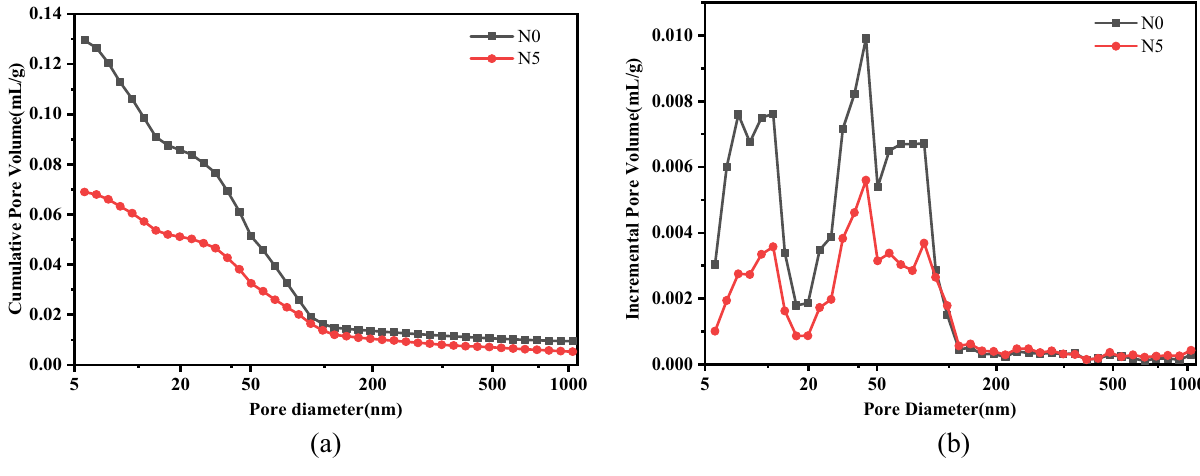
Figure 12: MIP test results. ( a ) Cumulative pore volume. ( b ) Pore size distribution.